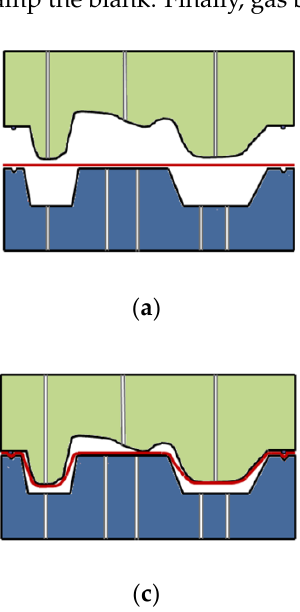
Figure 1. The schematic of a high-speed blow forming (HSBF) process: ( a ) pre-heating the blank on the lower die; ( b ) crash forming; ( c ) clamping the blank; ( d ) gas blow forming.